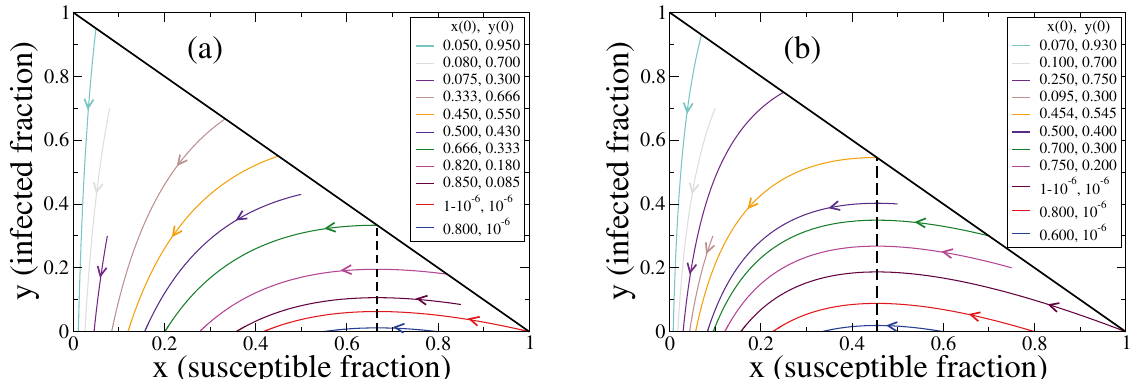
Figure 1. Trajectories of the system in the x − y phase space for the SIR model Eq. (1) with basic reproduction number σ = 1.5 ( a ) and σ = 2.2 ( b ), where x and y are the fractions of susceptible and infected individuals, respectively. Each curve corresponds to a trajectory starting from a given initial condition ( x (0), y (0)), as indicated in the legends. Arrows denote the direction of the time evolution of x and y . The vertical dashed line corresponds to the critical value x = 1 /σ where y ′ = 0